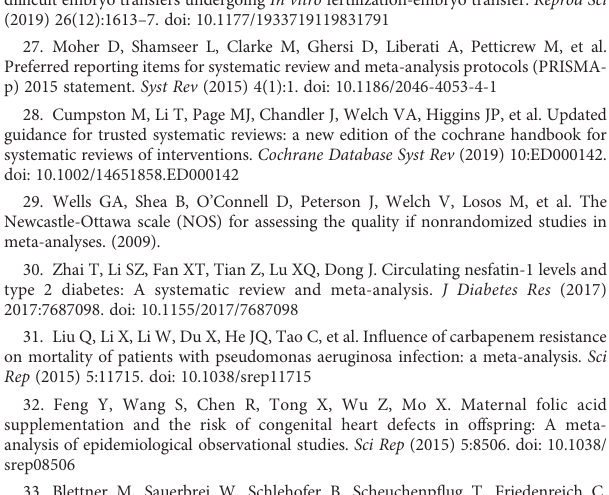
SUPPLEMENTARY FIGURE 3 Forest plots of live birth rate. SUPPLEMENTARY FIGURE 4 Forest plots of implantation rate. SUPPLEMENTARY FIGURE 5 Forest plots of miscarriage rate. SUPPLEMENTARY FIGURE 6 Forest plots of multiple pregnancy rate.